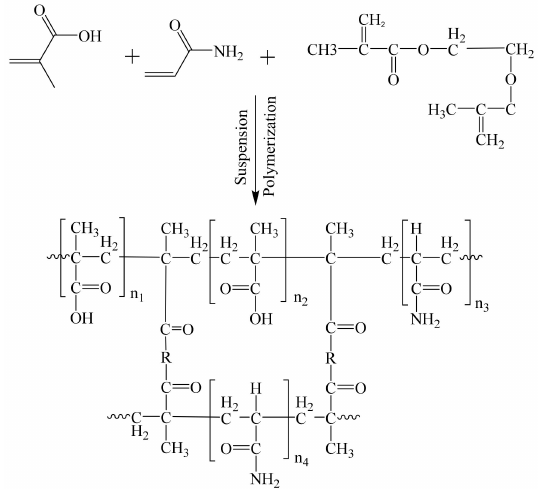
Figure 1. The scheme for preparing the Bi-MIPs (R is -O-CH 2 -CH 2